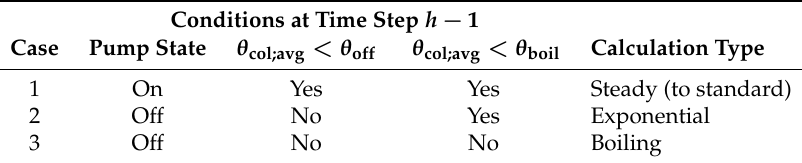
Table 1. Calculation types according to collector temperature